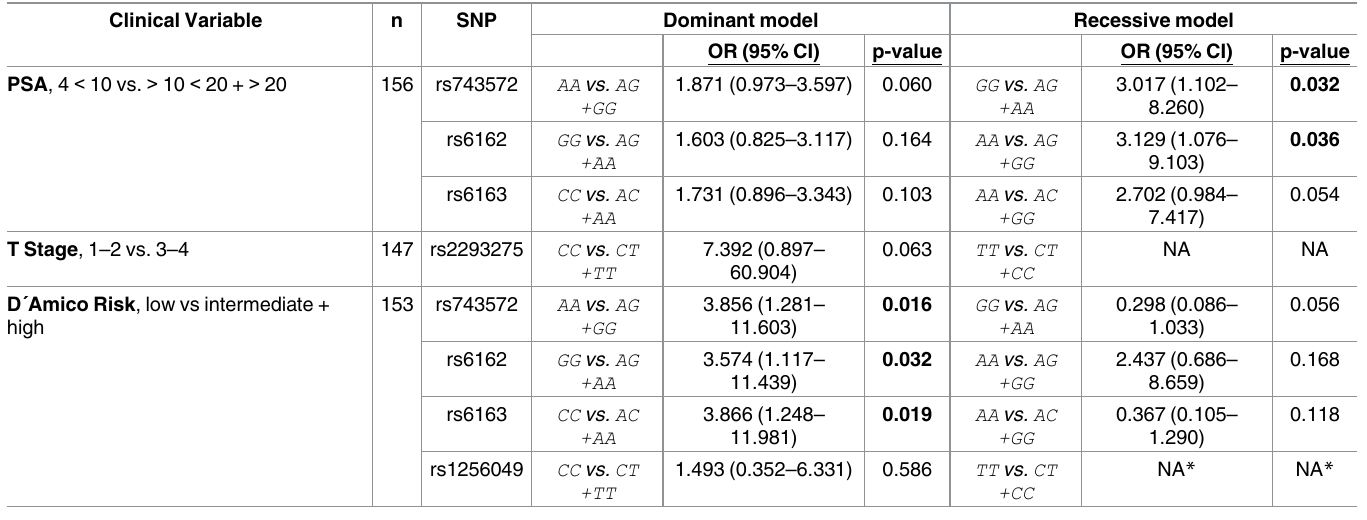
Table 4. Multivariate analysis for differentially distributed SNPs and clinical variables.